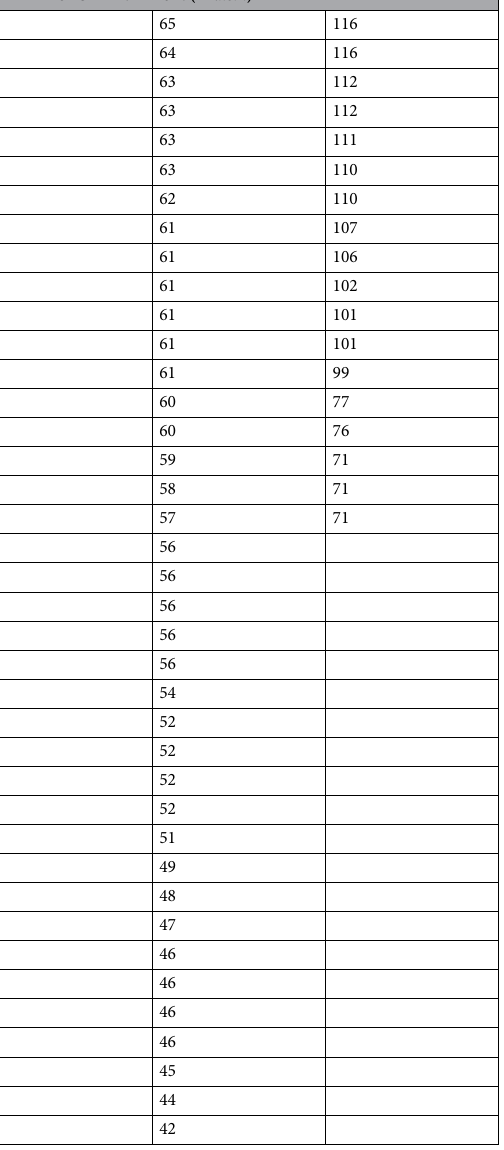
Table 1. Hilltop